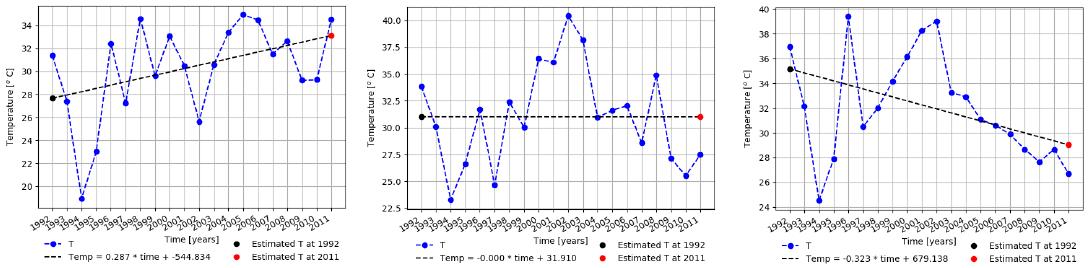
Figure 4: Trend of the least squares for different pixels: positive trend, constant trend, negative trend.